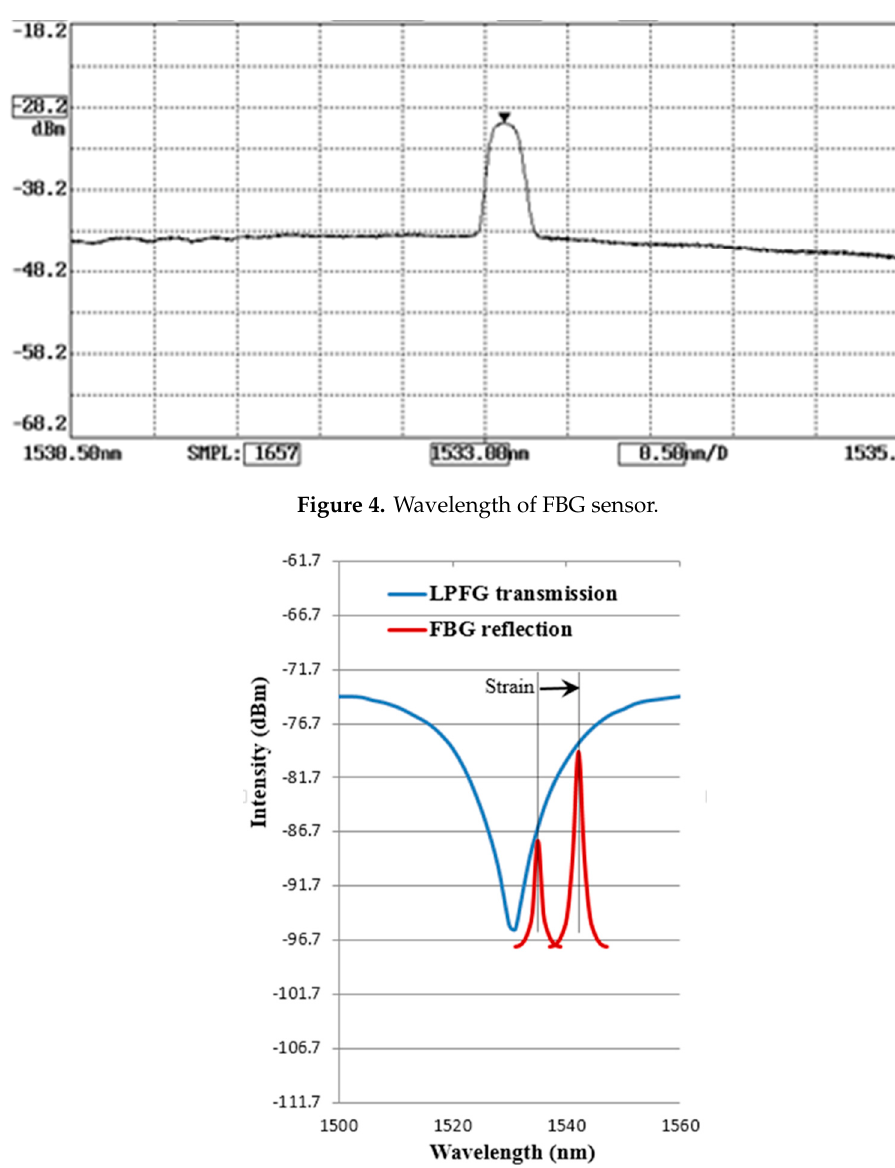
Figure 6. Relation between the strain and normalized light intensity. 4. Shock and Vibration Tests To validate the accuracy of the optical fiber sensor, experimental tests were conducted by subjecting a beam to base excitation, impact and drop tests. In the following tests, the FBG sensor is attached on a cantilever beam subjected to bending. The bending strain can be transferred from the beam to the FBG sensor, resulting in a shift of the Bragg wavelength reflected from the FBG sensor. The bending strain in the cantilever is position dependent. The main influence exerted by the position of the FBG in the cantilever beam is that the strain of the FBG varies with the position of the FBG on the beam. In this work, the FBG sensor was placed at the center of the beam. The effects of bending on the FBG include strain-induced wavelength shift and curvature-induced power loss. In this work, the bending curvature of the cantilever is small; therefore, the power loss can be neglected.